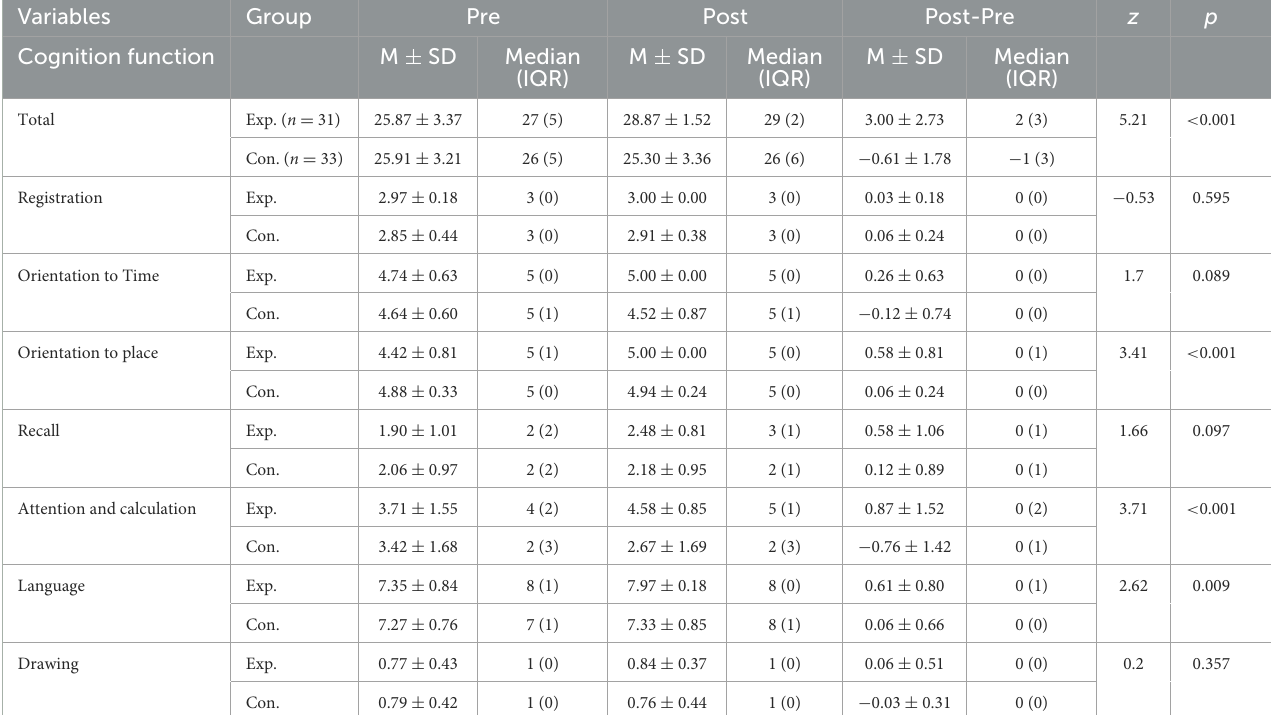
TABLE 3 Comparison of cognition function ( N = 64).